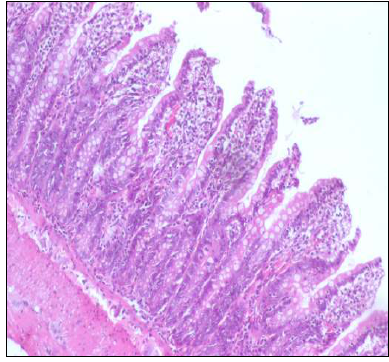
Figure-2. Histopathology image of kidney from Group IV rat showing desquamation of tubular epithelial cells, tubular necrosis in repeated 28 day toxicity study by H and E stain (200 X).